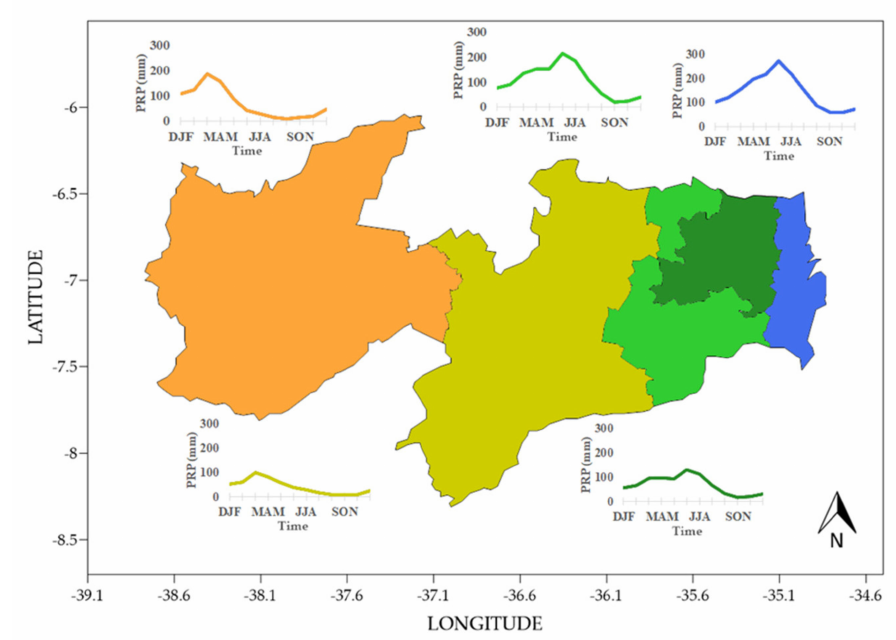
Figure 2. Distribution of the five homogeneous regions by cluster analysis in the state of Para í ba. (PRP = monthly precipitation, DJF = December, January and February; MAM = March, April and May; JJA = June, July and August; SON = September, October and November). Table 3. The time lag between Sea Surface Temperature (SST) anomalies and precipitation in the state of Para í ba (SOI = Southern Oscillation Index; AMO = Atlantic Multidecadal Oscillation; PDO =